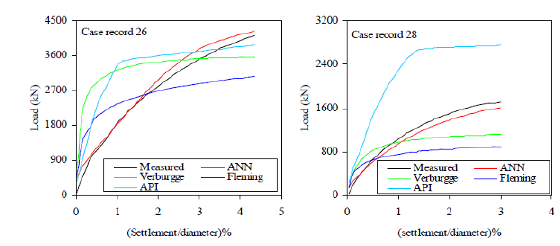
Figure 10. Comparison performance of ANN driven steel piles model and load-transfer methods.